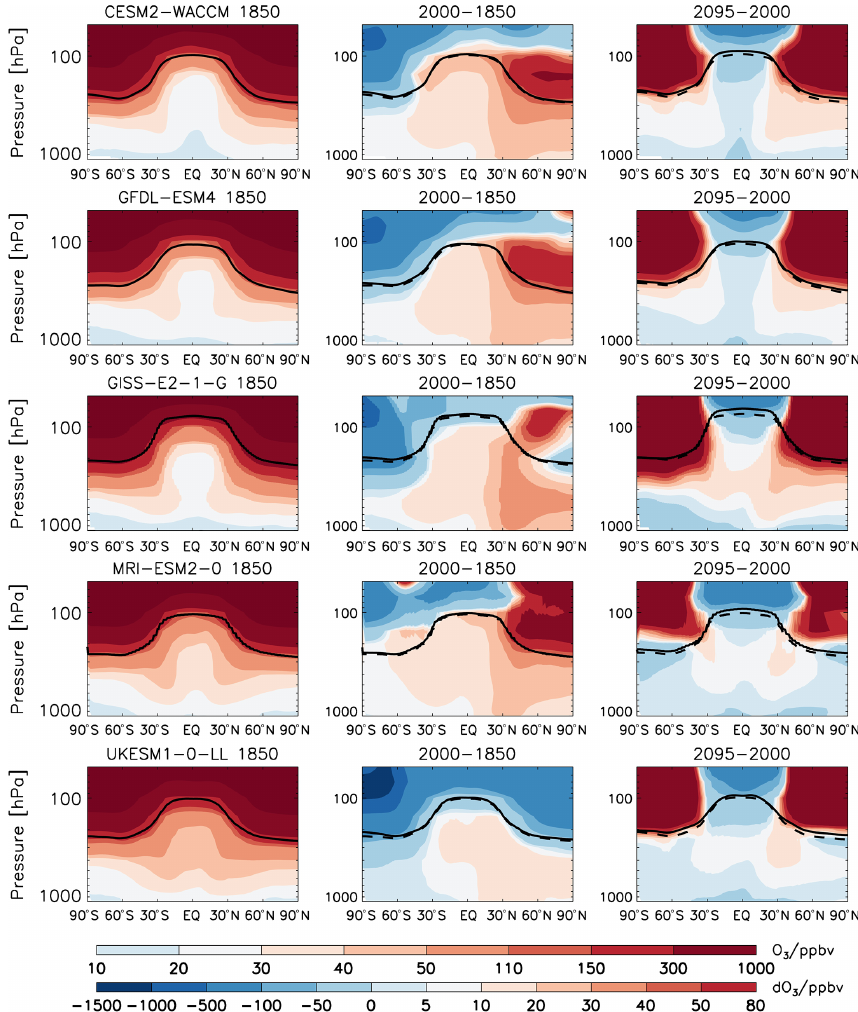
Figure 17. Annual and zonal mean ozone distribution in five models over the 1850s (averaged over 1850–1859) (left), the difference between 1850 and 2000 (averaged over 1995–2004) (middle), and the difference between 2000 and 2095 (2090–2099) (right). Thick black lines are the tropopause height of each model based on the WMO definition. Dashed black lines are the tropopause for the 1850 period (middle) and for 2000